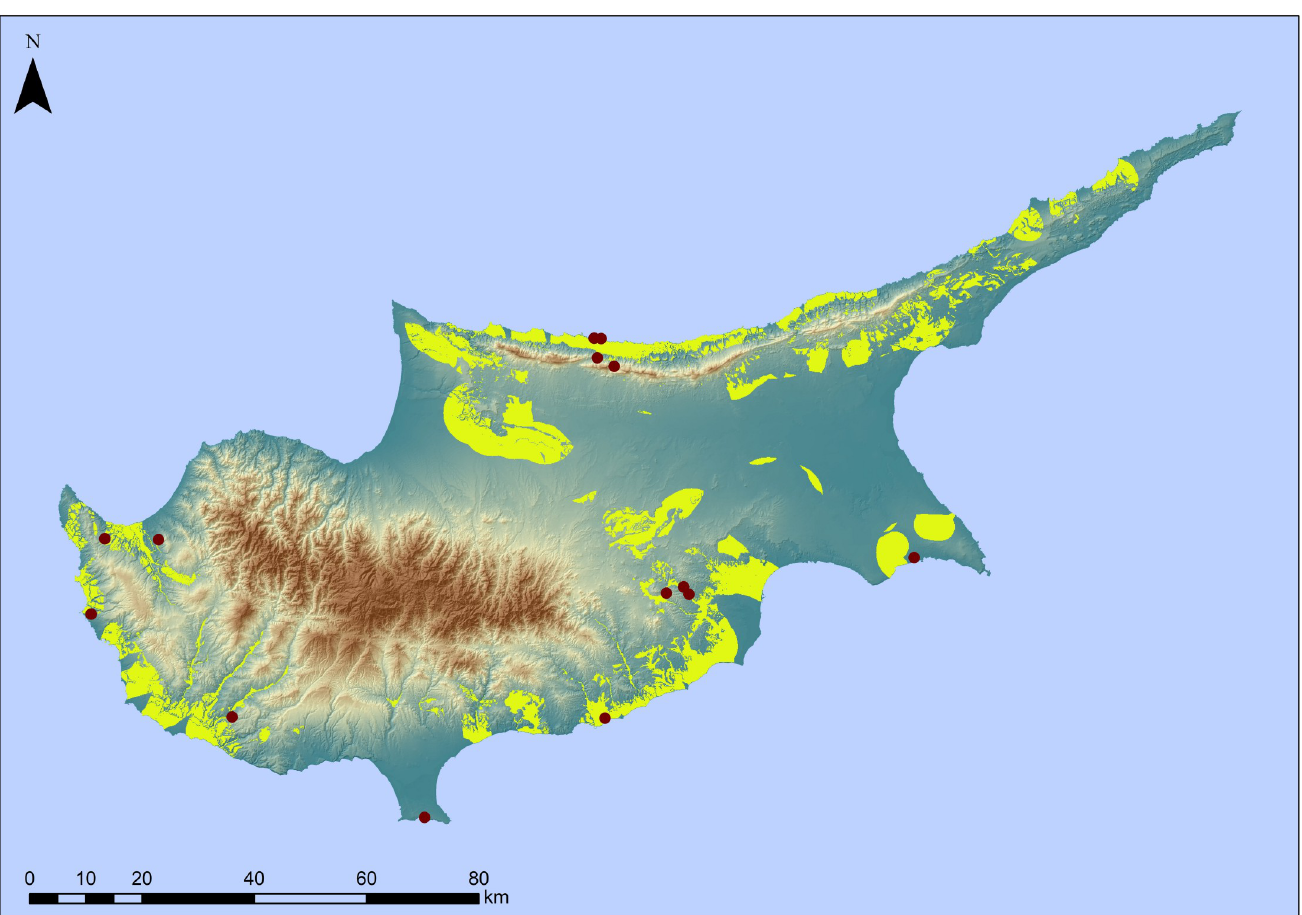
Fig 6. Prediction analysis final output. The map illustrates the final output of the predictive analyses, taking into account the combination of slope, elevation, aspect, distance from coast and rivers results as well as Pleistocene terrestrial geology and raw material availability. The map delineates the smallest possible area of high potential to preserve Pleistocene archaeology based on the currently available data (green zone). The dark red dots indicate the location of known early archaeological sites on Cyprus (see Fig 1 for site names). Original copyright with the authors.